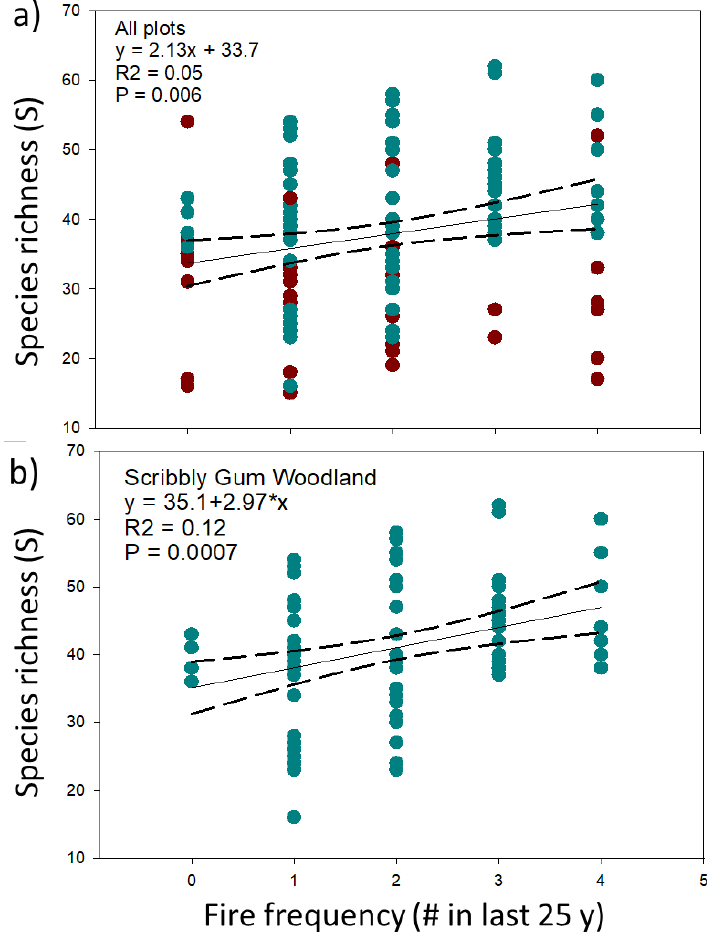
Figure 7. Species richness (S) increases with fire frequency ( a ) across all plots and ( b ) especially within SGW. Assumptions of normality and equal variance were met. Symbols are the same as in Figure 5.